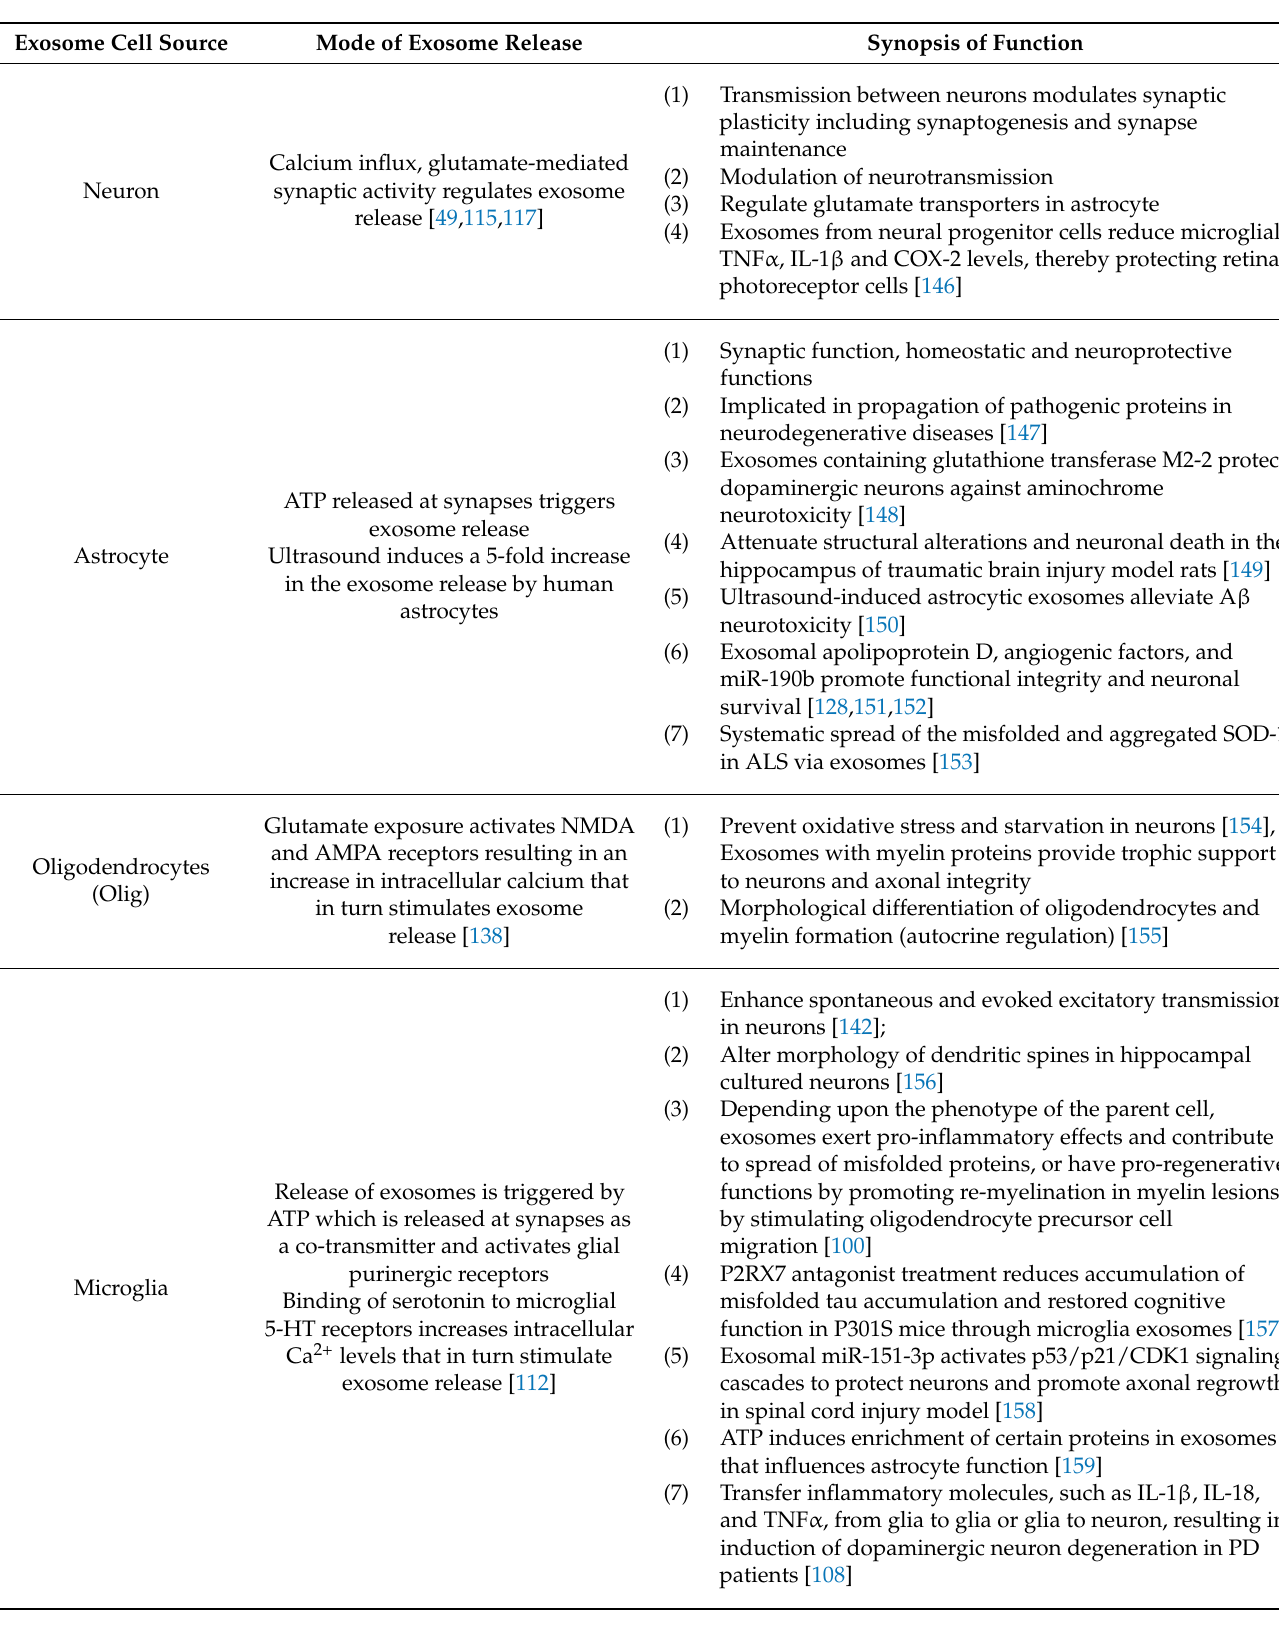
Table 2. Role of cell-specific exosomes in intercellular communication among brain